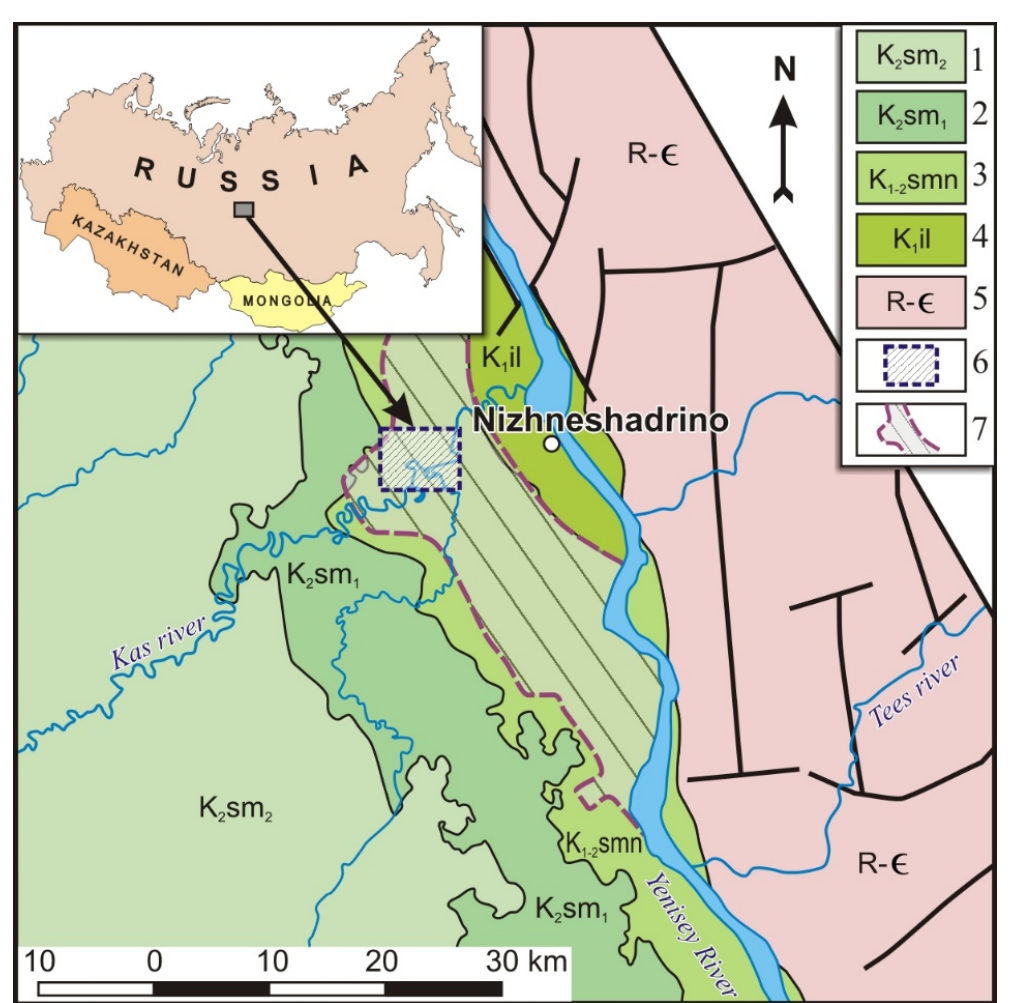
Figure 3. Geological map showing the location of the Nizhne-Kas germaniferous lignite area [38]. Note: 1—Upper Cretaceous system, Campanian–Maastrichian stages, Symskaya Formation, upper subformation, Vari-grained quartz sand kaolinized with interlayers of kaolin clay and lignite; 2—Upper Cretaceous system, Cognac–Santonian stages.; Symskaya Formation, lower subformation., Vari-grained quartz sand with interlayers of kaolin clay; 3—Lower-Upper Cretaceous system, Albian-Cenomanian-Turonian stages, Simonovskaya Formation, Lake-alluvial deposits, Quartz sand with interlayers of clay and poorly lithified sandstone, germaniferous lignite; 4—Lower Cretaceous system, Valanginian–Barremian stages, Ilek Formation, Variegated clay and clayey sand with interlayers of siltstone, mudstone, sandstone, and inclusions of plant residue; 5—Riphean-Cambrian crystalline basement., Metasedimentary rock including granitoid, gabbroid, and ultrabasic bodies metamorphosed to amphibolite and greenschist facies; 6—The Serchanskoe Ge deposit; 7—Outlines of the Nizhne-Kas lignite deposit.